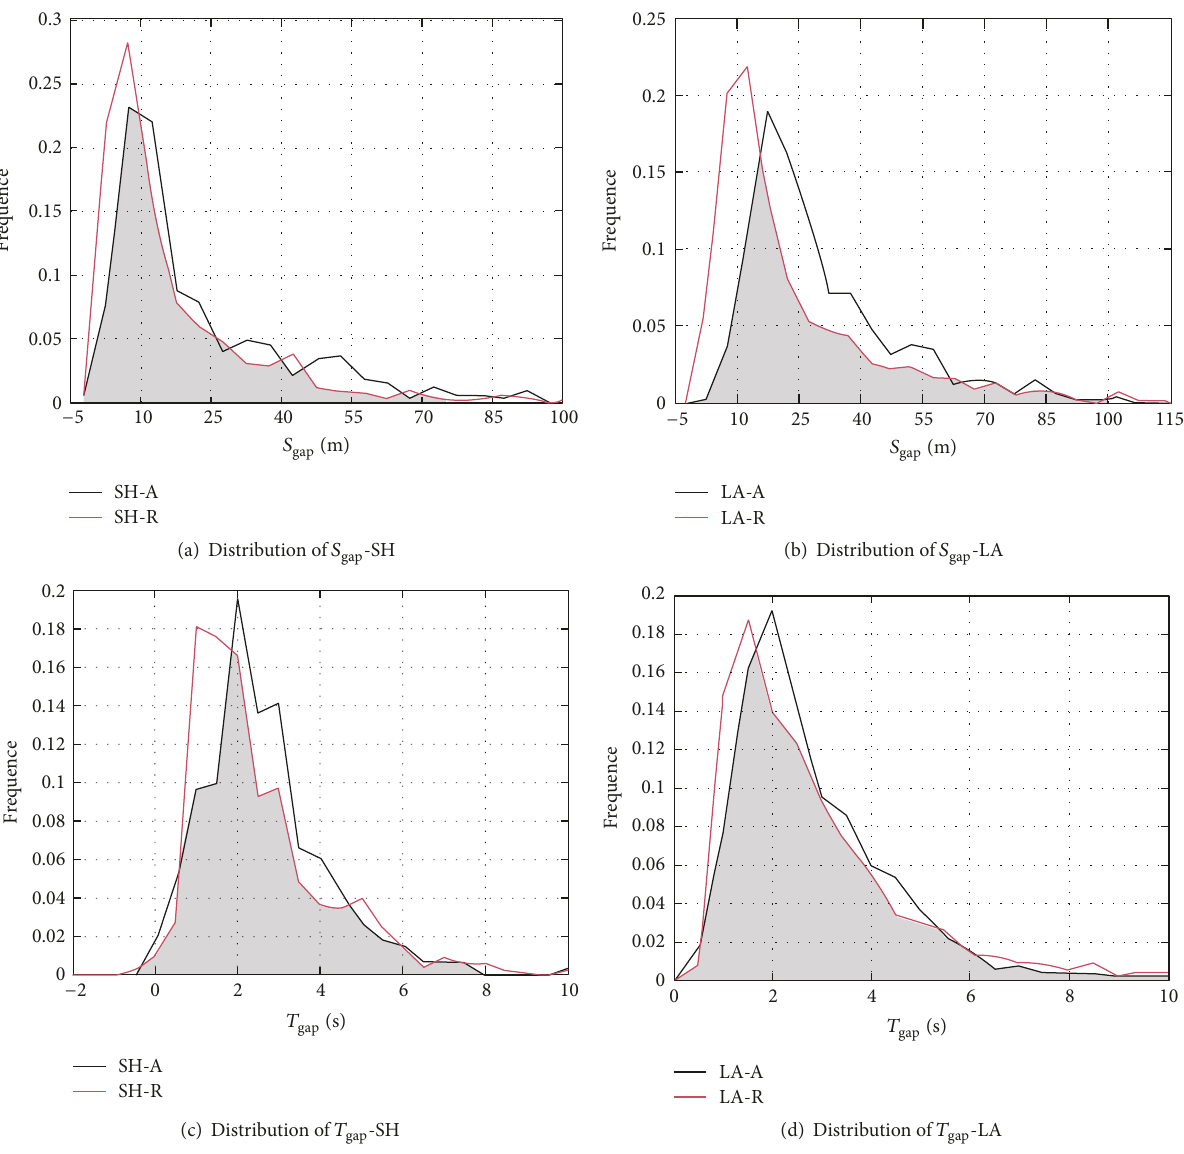
Figure 6: The distribution of 𝑆 𝑔𝑎𝑝 and 𝑇 𝑔𝑎𝑝 in SH and LA (note that SH-A and LA-A represent the accepted gaps in SH and LA, and SH-R and LA-R represent the rejected